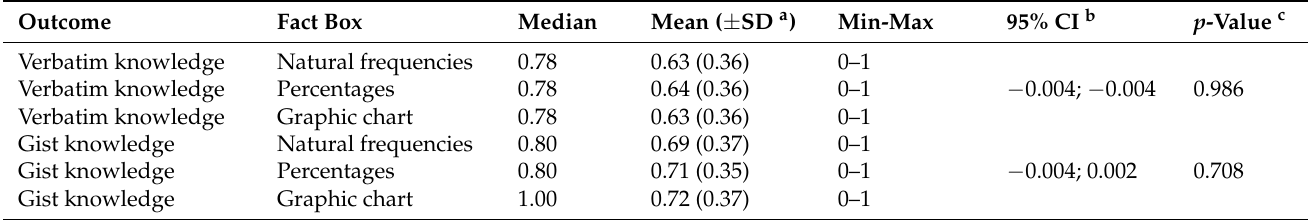
Table 2. Primary outcome: verbatim and gist knowledge (sum score).